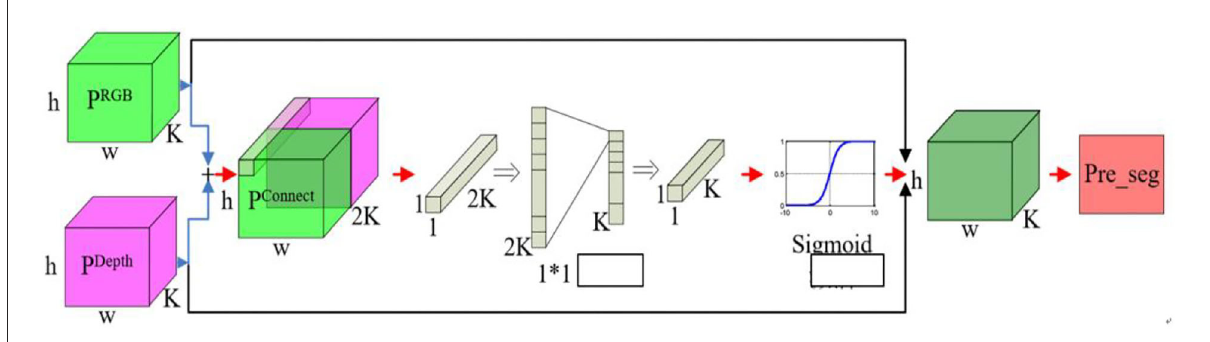
FIGURE6 Contribution trade-off prediction process diagram.